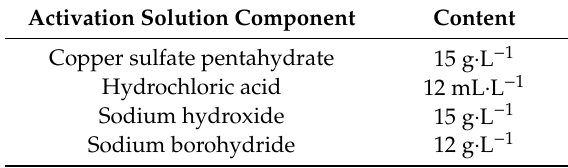
Table 2. Activation